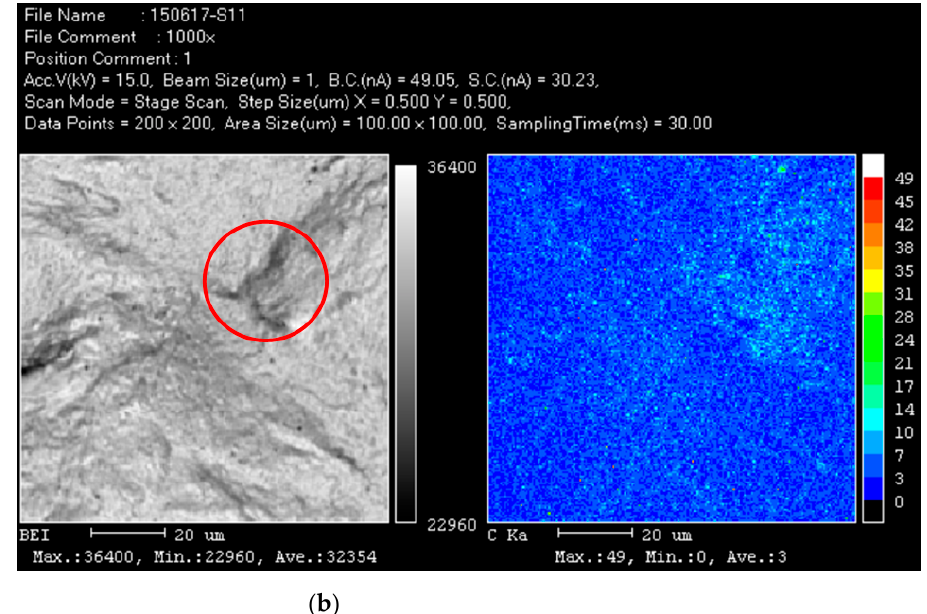
Figure 12. Electron probe scanning results of the welded specimen. ( a ) Specimen 4 ( σ a = 480 MPa, N f = 9.36 × 10 6 ); ( b ) Specimen 18 ( σ a = 500 MPa, N f = 1.09 × 10 7 ).